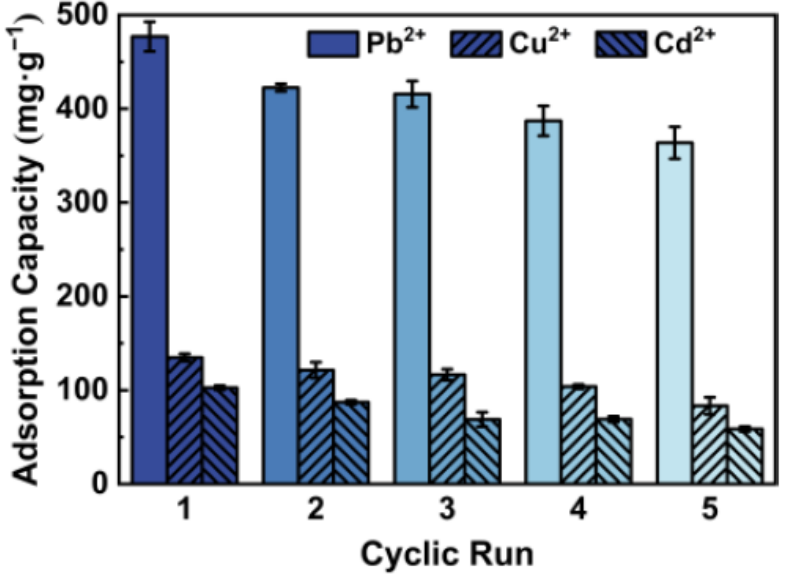
Figure 8. Reusability after cyclic run of CTS/CA/BT composite hydrogel.